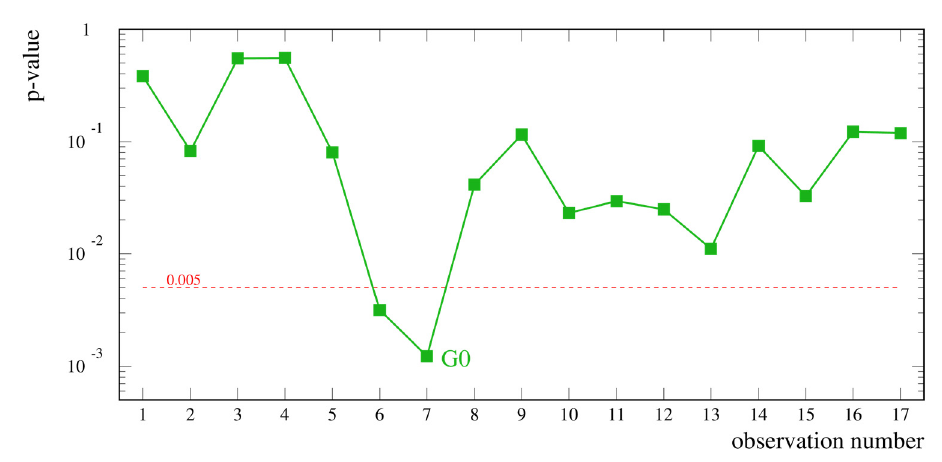
Figure 6. The time evolution of the p -value of the 1a hypothesis.